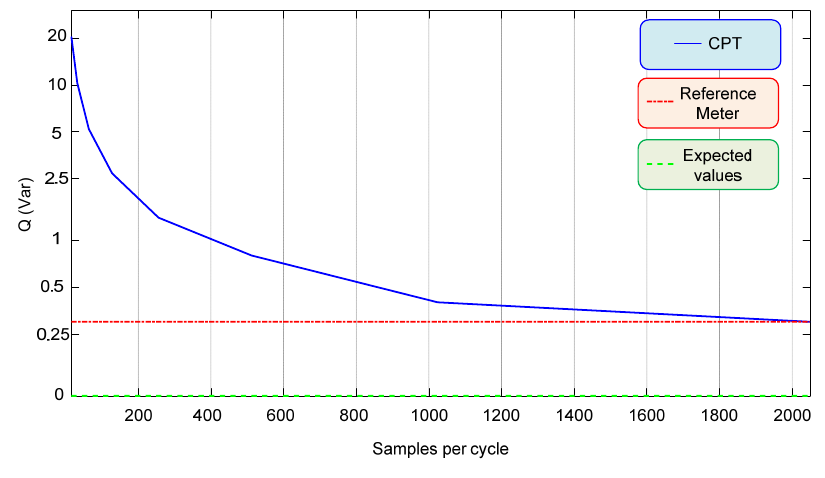
Figure 2. Reactive power for one resistive load.